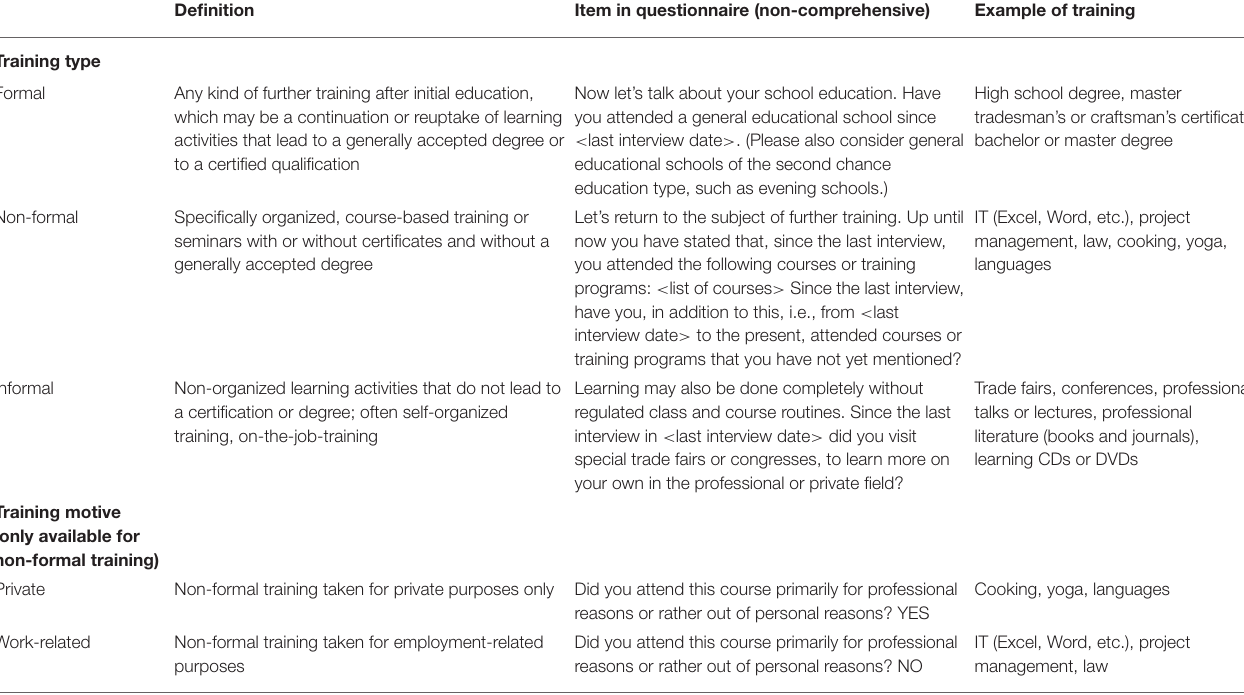
TABLE 2 | Definition and examples for training types and